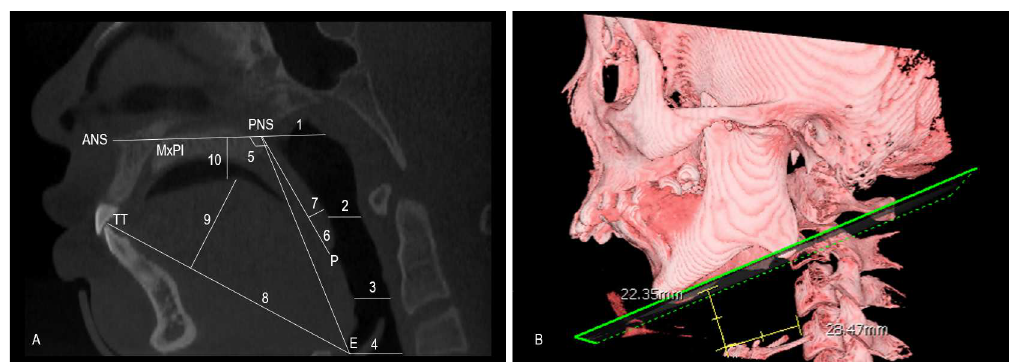
Fig 2. Upper airway measurements. Relevant2D points and 10 items related to the midsagittalplane (A):ANS; PNS; ut; P; TT; E; MxPl; 1 Nasopas; 2 Velo Pasmin; 3 Oropas; 4 Hypopas; 5 SP position;6 PNS-P; 7 SP thickness; 8 Ton length; 9 Ton height; 10 Ton position[6]. Relevant3D points and 4 items related to volume (B):AH: the most anterosuperiorpoint of the hyoid bone; MP: the plane passingMe, Go and Go’; VP: the plane crossing the anterior border of C3 and C4 and parallelingits long axis C3 and C4; AH-MP: the distancebetweenAH and MP; AH(Z): the distancebetweenAH and VP; Pasmin area: the smallest area of the cross section of the upper airway; Airway volume:the volume of upper airway betweenthe Nasopasline and Hypopasline.